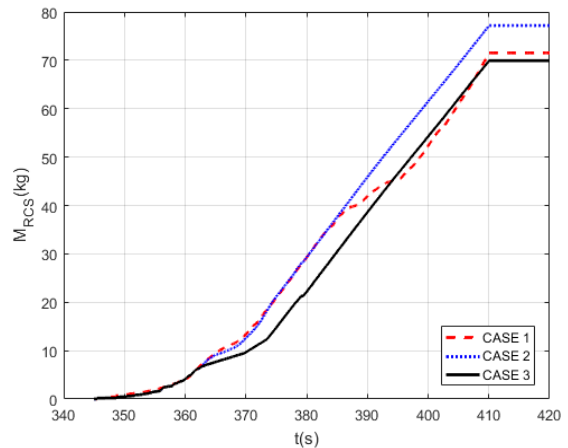
Figure 10. The fuel consumption comparison.